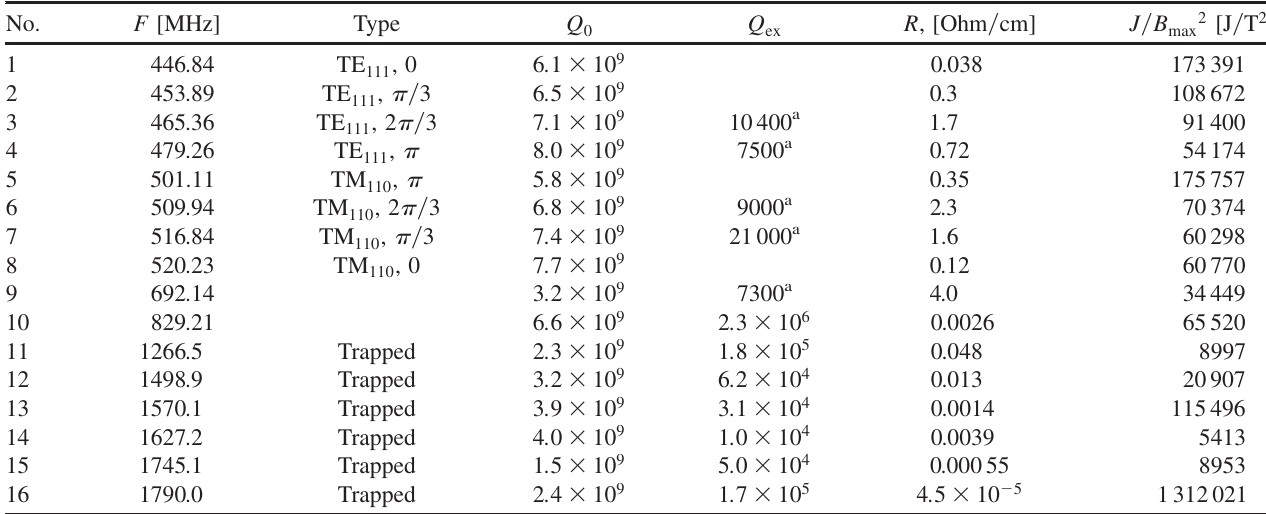
TABLE I. Performance of the LEP cavity dipole